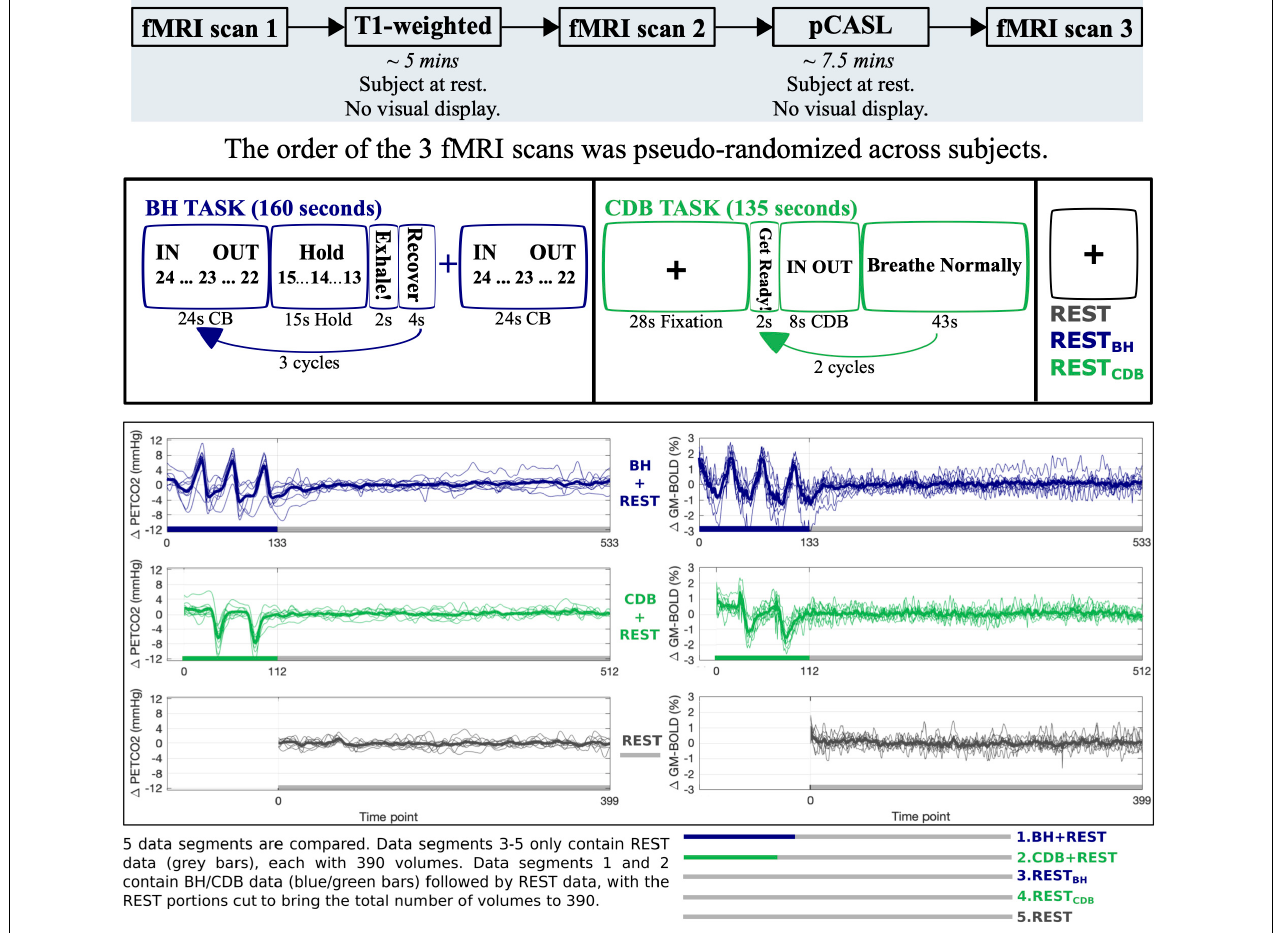
FIGURE 1 | The top panel shows the study protocol. The middle panel shows the display and timings for the Breath Hold (BH) task, Cued Deep Breathing (CDB) task, and REST sections. Visual instructions for each task were displayed on a monitor during scanning. For the BH task, IN and OUT instructions alternated for 3 s each, with a countdown from 24 s. Subjects ended on an exhale before holding and were instructed to do another exhale after holding. “Recover” is a period of free breathing. For the CDB task, IN and OUT instructions alternated for 2 s and subjects were told to take fast, deep breaths. The bottom panel displays the P ET CO 2 hrf traces (mmHg change from baseline) and GM-BOLD traces (% change from mean) for each fMRI acquisition. Each acquisition included 8 min of REST (gray), one acquisition preceded this with a BH task (blue) and one acquisition with a CDB task (green). From these three scans, five data segments of equal length were created. The first 10 volumes at the start of each data segment are not used (discarded to allow the signal to achieve a steady state of magnetization for BH + REST, CDB + REST and REST segments, and therefore matched for REST BH and REST CDB ) resulting in 390 volumes for each data segment. Thick lines represent group means, and thin lines represent each